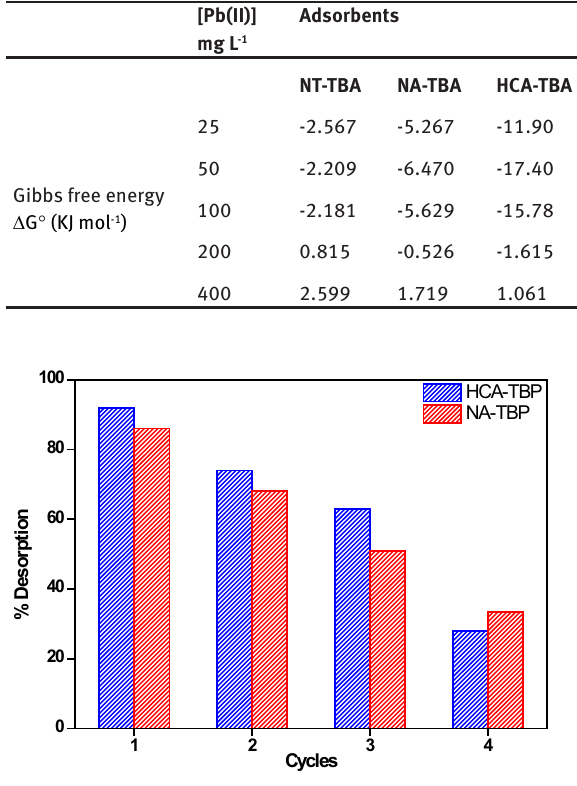
Figure 6: Desorption efficiency of HCA-TBP and NA-TBP in four cycles using 0.1 M EDTA.